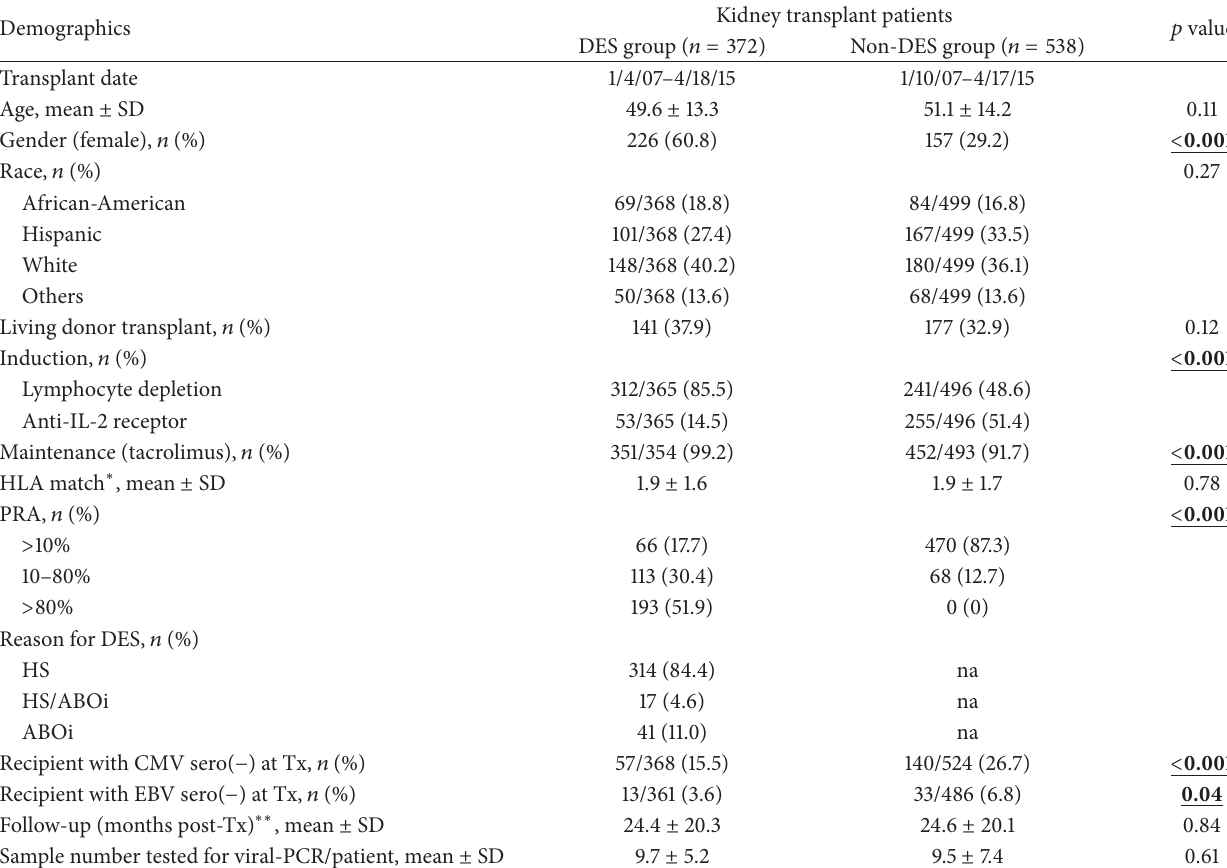
Table 1: Patient